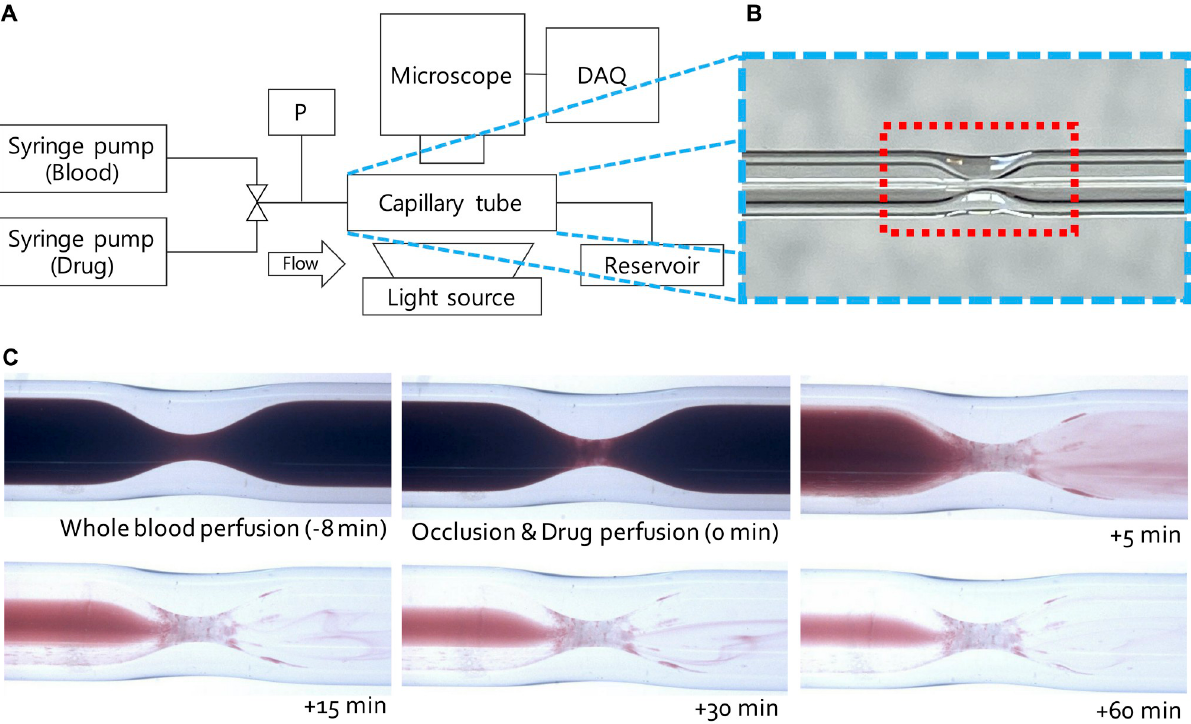
Fig 1. The in vitro perfusion system for creating platelet-rich, occlusive thrombi under arterial high shear rates, followed by perfusion of known and potential lytic agents. A Schematic of the arterial flow setup. B Close-up of the glass capillary tube with stenosis, which is coated with fibrillar collagen prior to perfusion. The red box denotes the region of interest. C Thrombus formation and subsequent perfusion with a phosphate-buffered saline (PBS) control, showing no lysis at the end of the experiment.